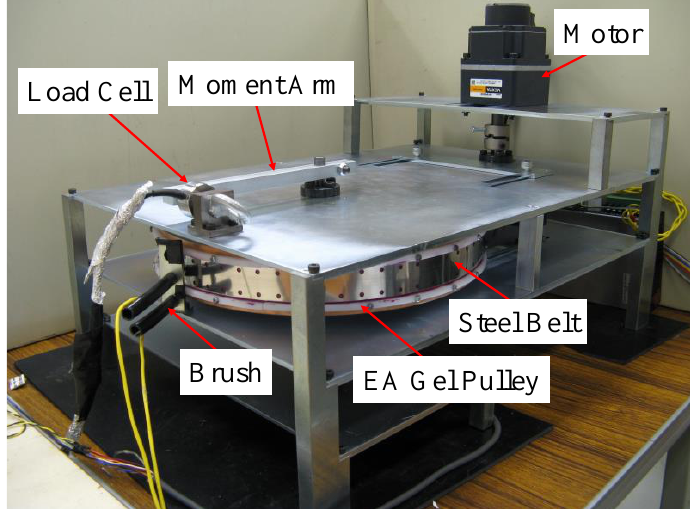
Figure 14. Testbed for a winding EA gel sliding alongside.